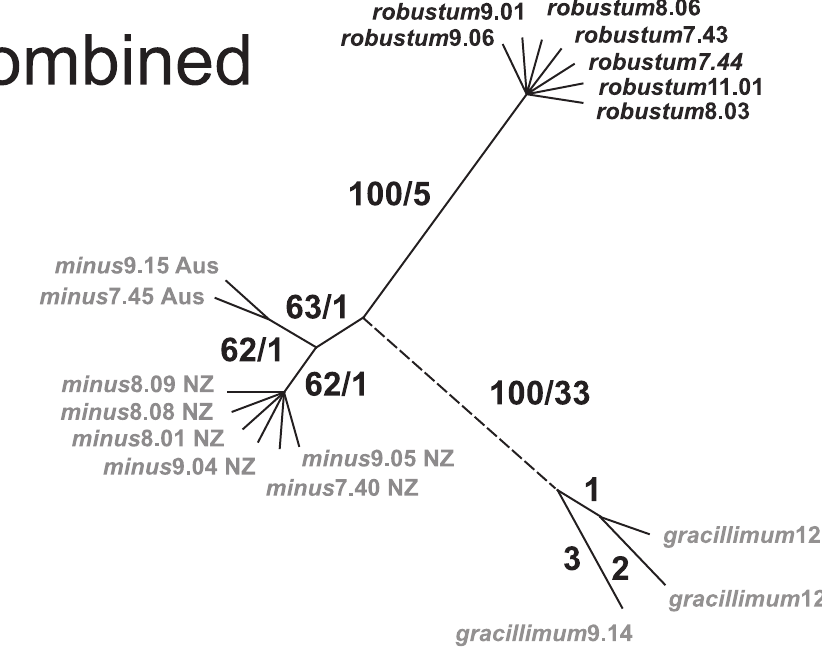
Figure 5. Unrooted parsimony tree from a combined analysis of the three sequence partitions. Six dis- tinct cpDNA haplotypes are supported. Bootstrap values / the number of mutations distinguishing each haplotype are shown beside the branches. The accessions of Empodisma minus from New Zealand are indicated NZ and Australia